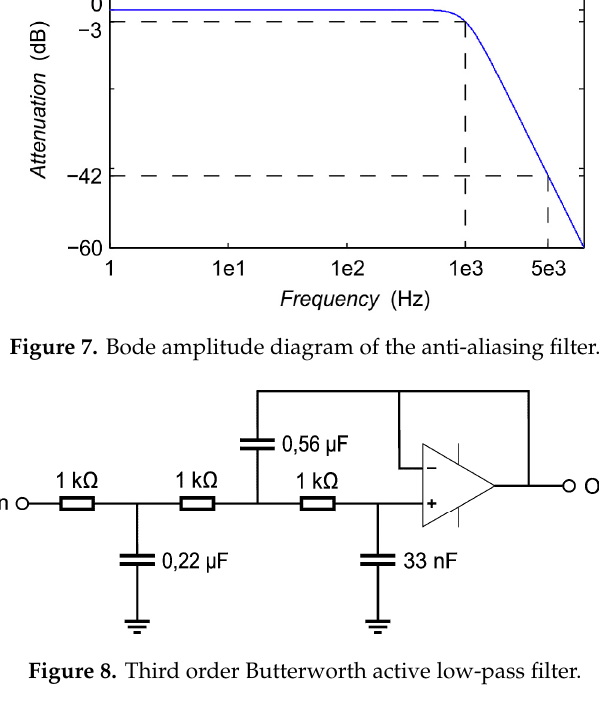
Figure 8. Third order Butterworth active low-pass filter.